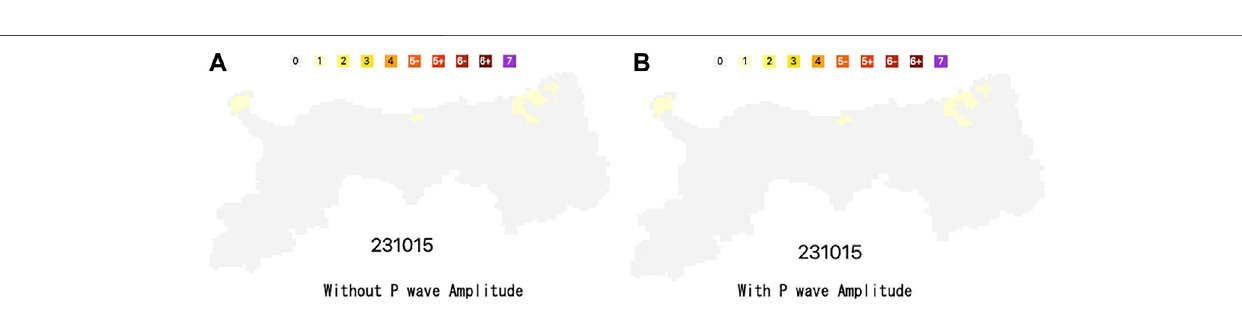
FIGURE 14 | Final seismic intensity distribution of the 2021 Off Fukushima Prefecture Earthquake estimation with the P wave (A) and without the P wave (B) .